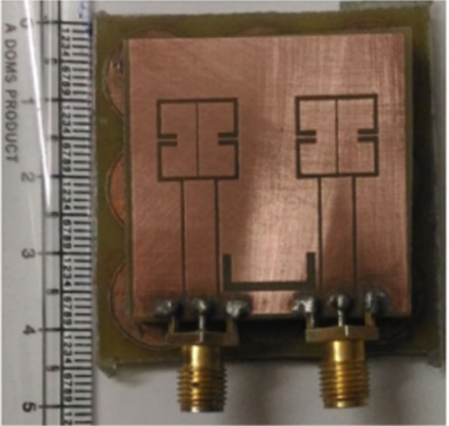
Figure 10. Prototype of CPW-fed MIMO design [47].